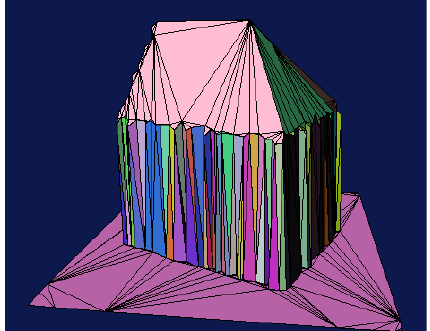
Fig. 9. Updated segmentation after removal of vertices at intersection.